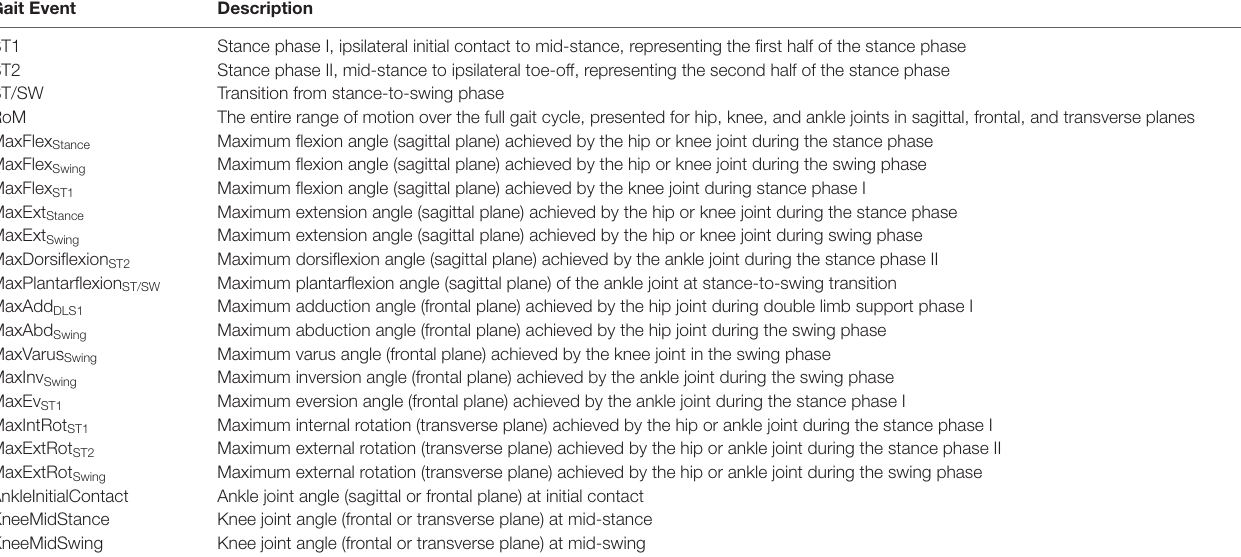
TABLE 2 | Gait event descriptions and abbreviations.